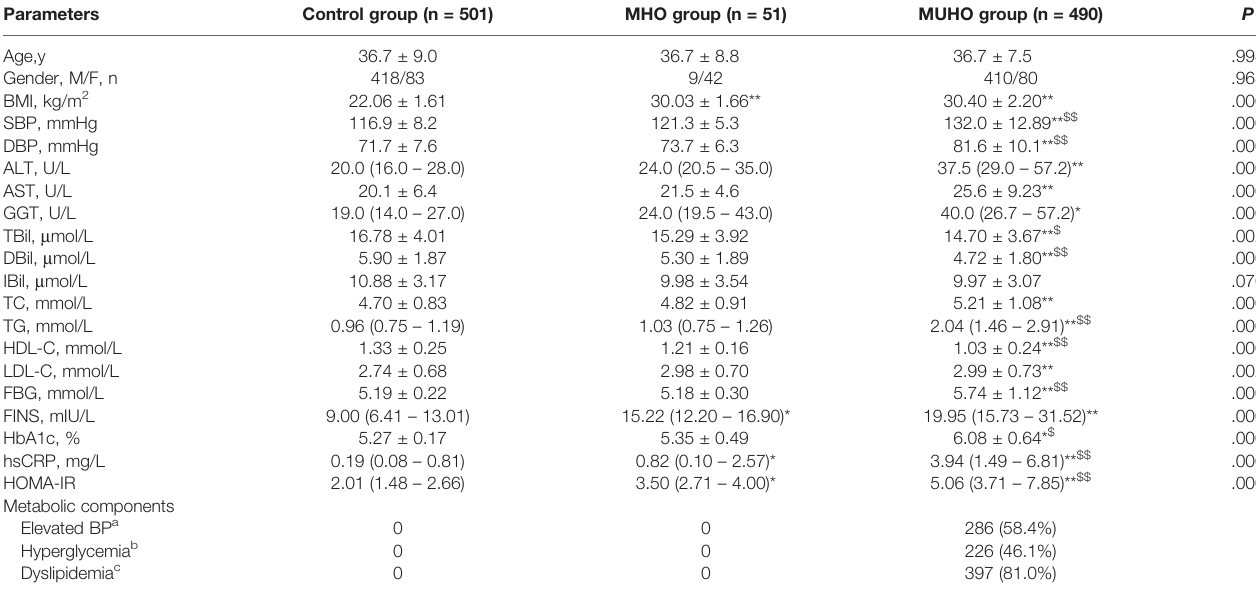
TABLE 1 | Baseline characteristics of control, MHO and MUHO groups.